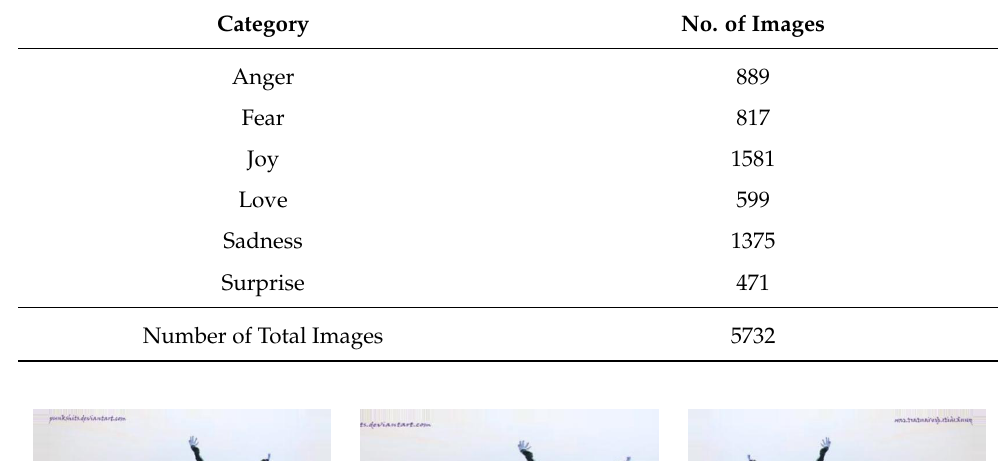
Table 7. Statistics of the applied dataset.